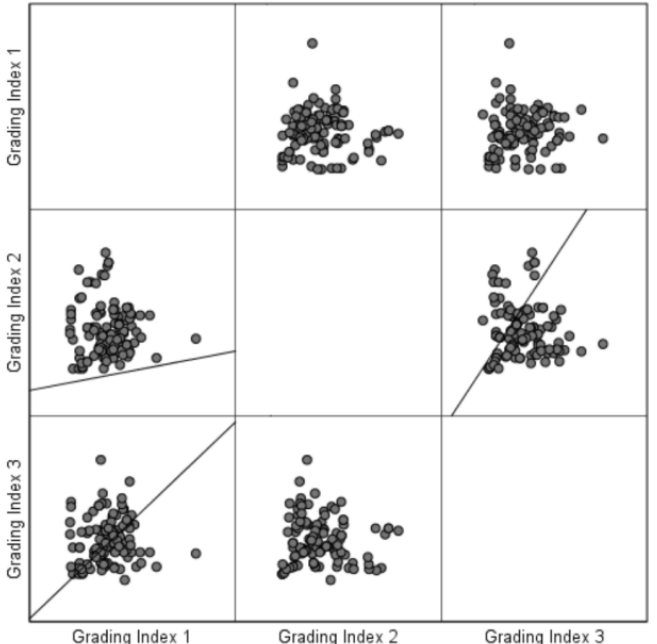
Figure 4. The relationship and trend of changes among hierarchical prediction indexes.